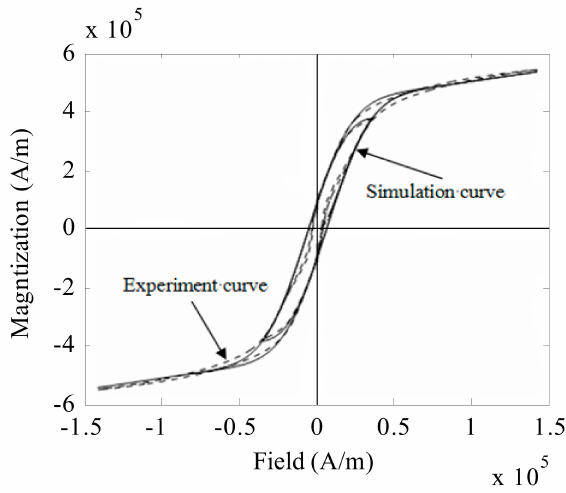
Figure 8. Simulation and experimental comparison curves of magnetization and magnetic field strength.